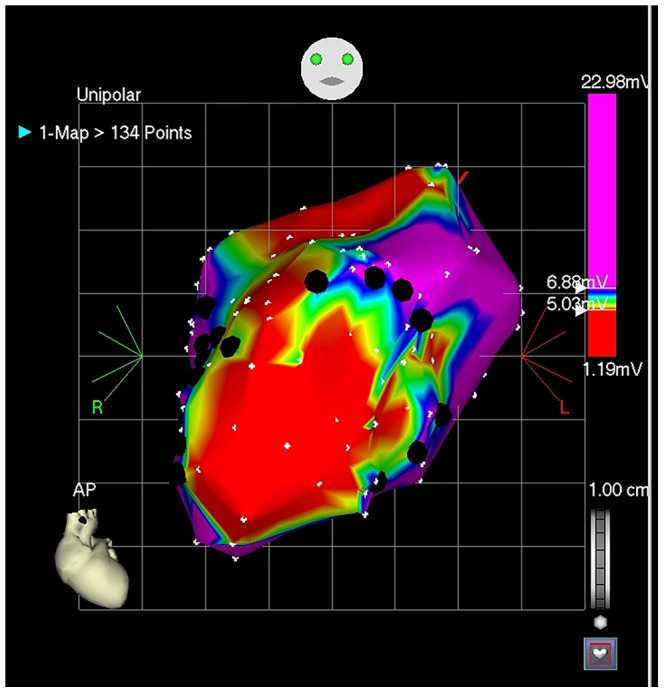
NOGA-guided transendocardial injections.Left ventricular electroanatomic map created by the NOGA XP Cardiac Navigation System. Red indicates scar tissue. Black dots indicate injection points into the infarct border zone.